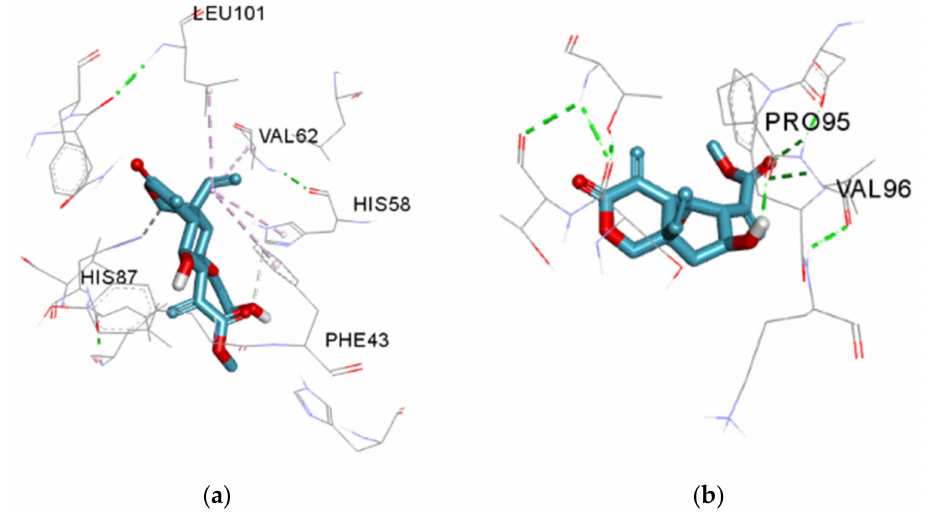
Figure 8. Deoxyhemoglobin S (PDB ID: 2HBS) ( a ) Lowest energy docked pose of vernodalol ( b ) Lowest energy docked pose of lasiopulide. Conventional Hydrogen bond (solid green colour), carbon-hydrogen bond (solid grey colour) and Pi-Alkyl (solid lilac